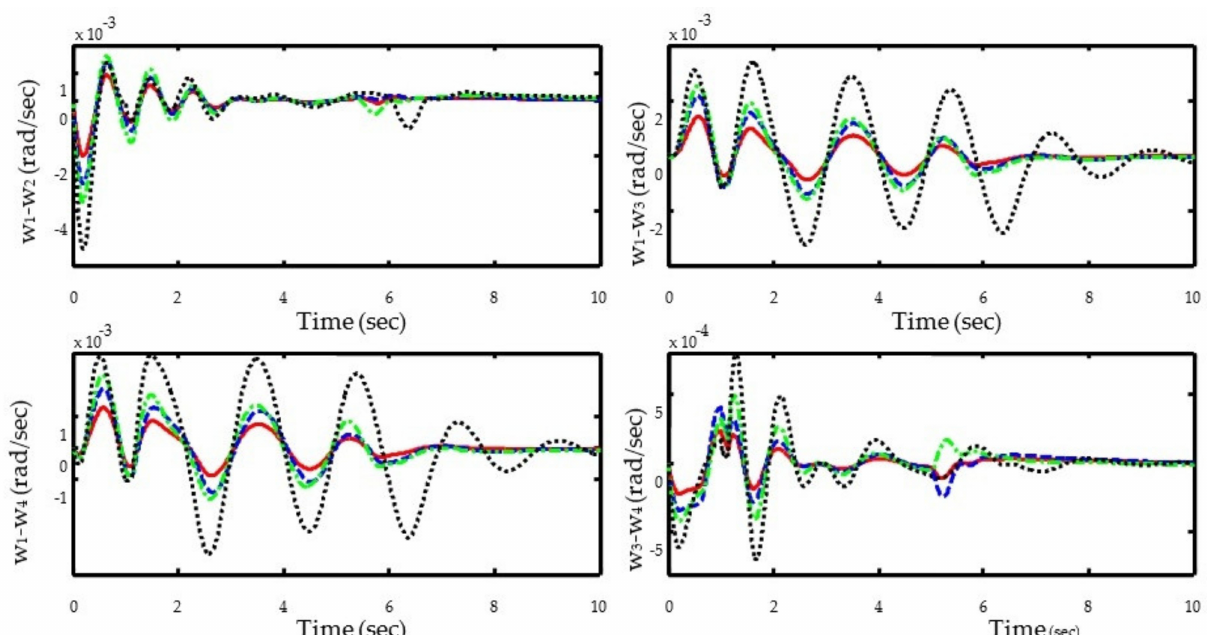
Figure 8. Angular velocity deviation for the first scenario for low load; proposed (red line), BFA (blue dashed line), GA (green dash–dotted line), classic (black dots).